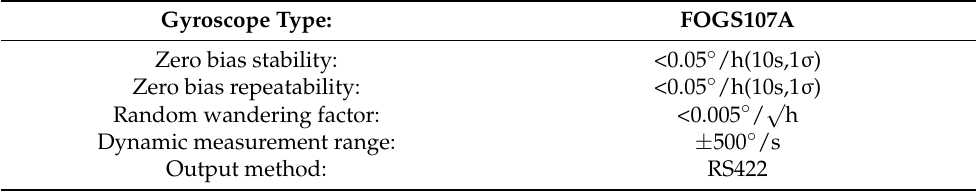
Table 2. Sensor technical parameters.